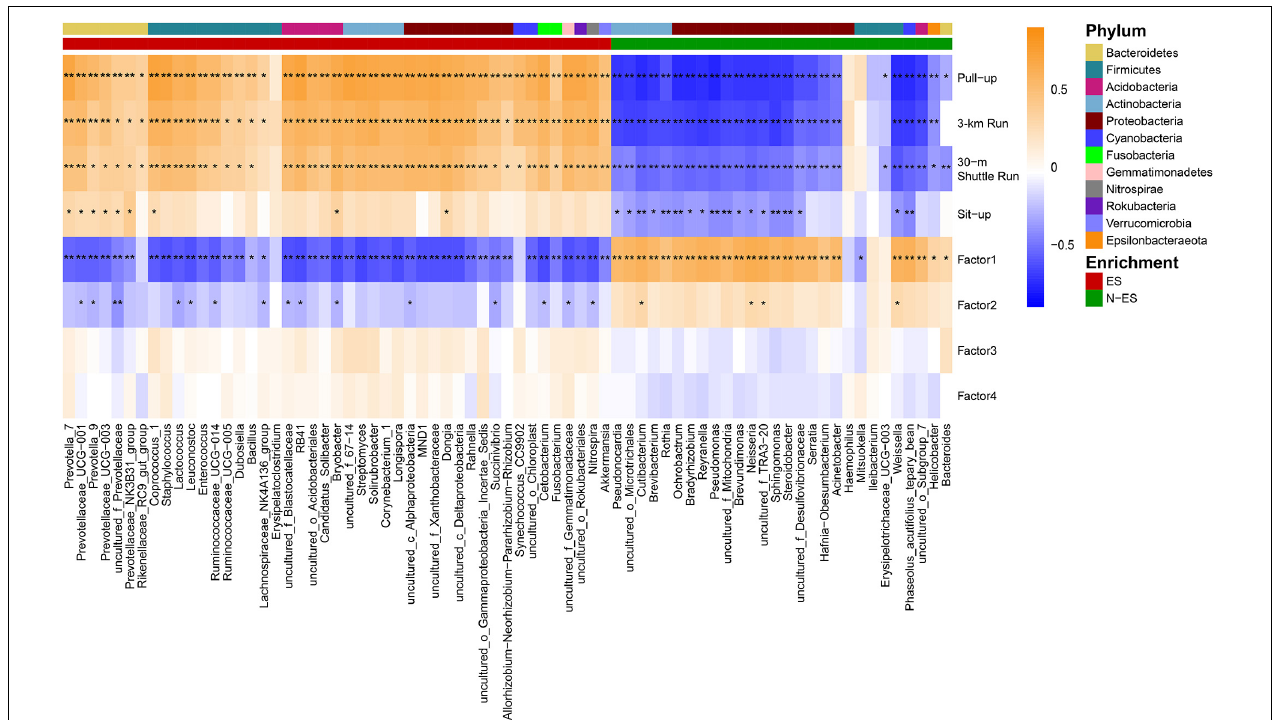
FIGURE 3 | Correlations between the members of the gut microbiome with physical phenotypes. Spearman’s rank correlations were calculated between dominant genera ( > 0.03%) and phenotypic scores. Higher taxonomy of genera (phylum) with enrichment in either ES or N-ES samples have been indicated by the colored bar at the top portion. The correlation effect is shown by a color gradient from blue (negative correlation) to orange (positive correlation). Black stars within heatmap boxes represent significant results (* P < 0.05, ** P < 0.001, Student’s t -test with false discovery rate correction for multiple